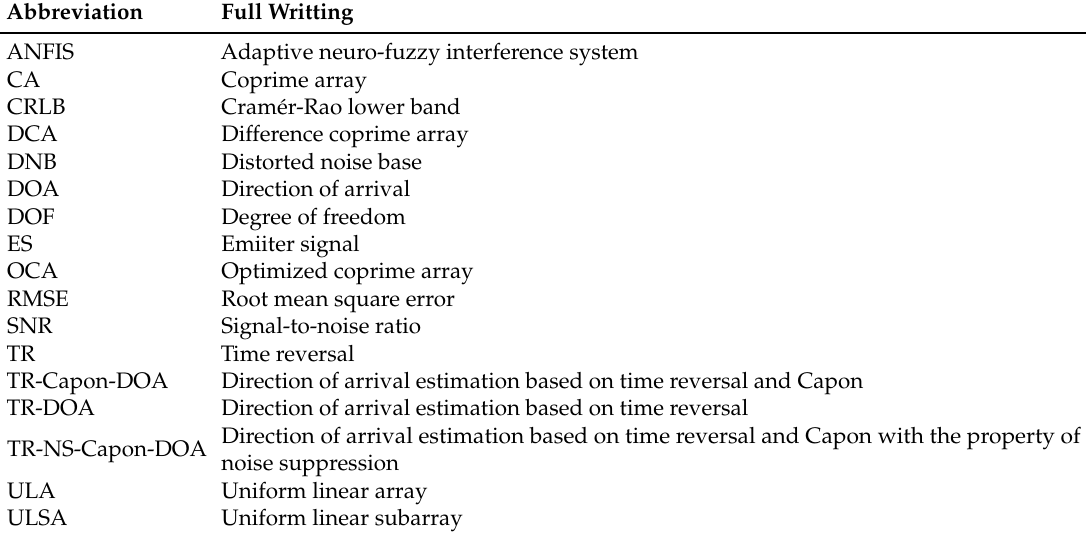
Table 1. Abbreviation used in the